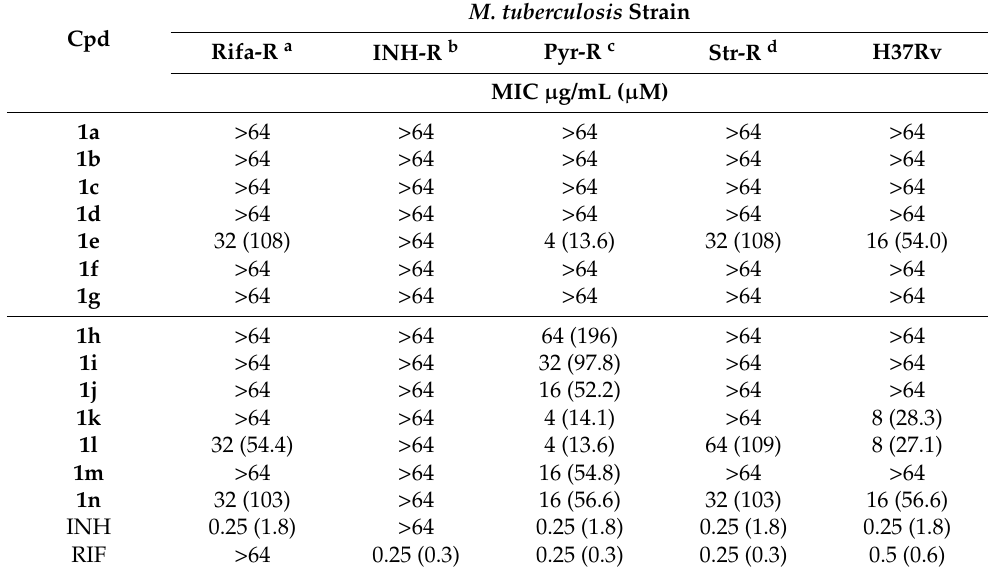
Table 2. Antimycobacterial activity of the final compounds 1a–n against different drug-resistant strains of M. tuberculosis and the virulent H37Rv